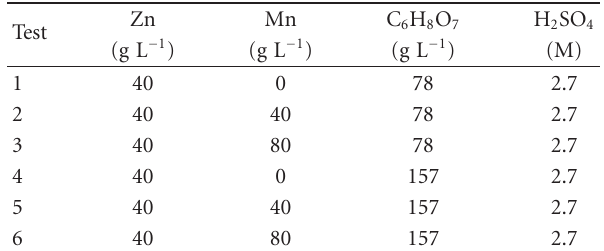
Table 4: Experimental conditions of the first series of precipitation tests: temperature 80 ◦